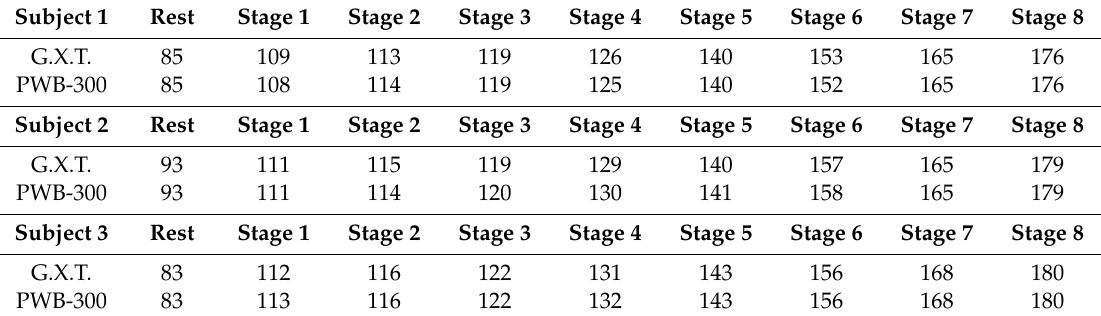
Table 8. Indoor GXT results.